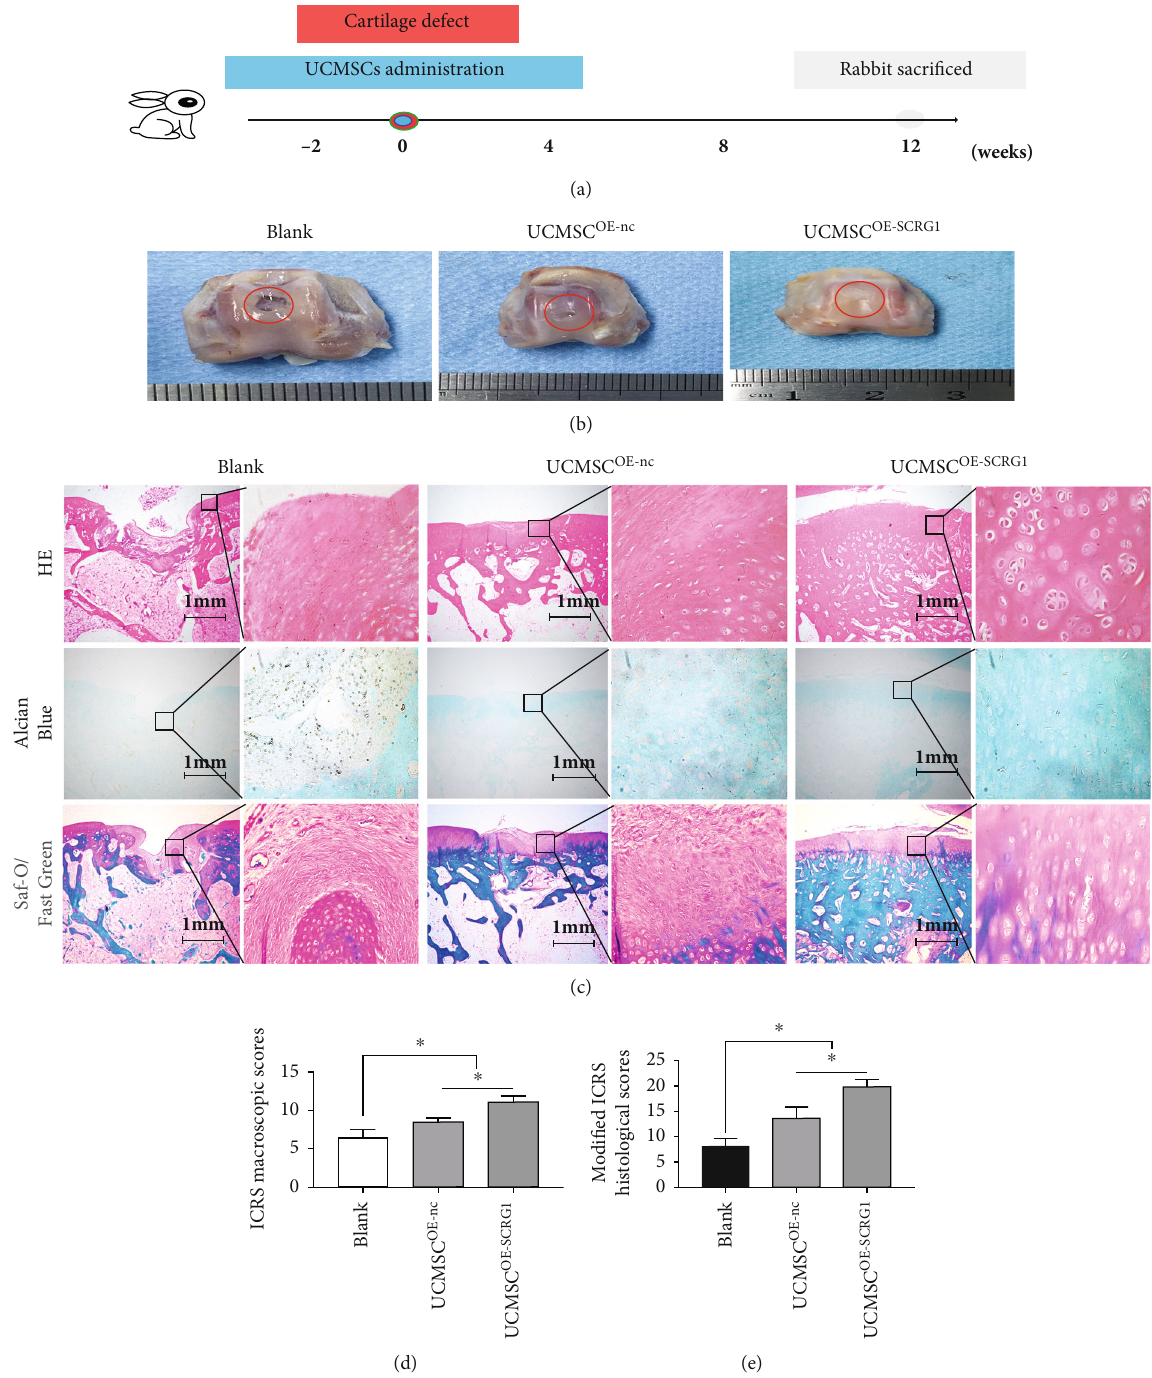
Figure 6: UCMSC OE-SCRG1 promoted cartilage defects repair in vivo . (a) Schematic of cartilage defect model and UCMSC administration. (b) Photographs of cartilage defects at 12 weeks after UCMSC administration. Obvious defects were observed in the blank group, whereas the surface was smooth and regenerated tissue was tightly connected to surrounding cartilage in the OE-SCRG1 group. (c) H&E, Alcian Blue, and Safranin O/Fast Green staining at 12 weeks after surgery. Results showed that defects in the blank group contained necrotic and fi brous tissue, while the OE-SCRG1 group showed considerable chondrocyte regeneration and tissue morphologies similar to normal surrounding cartilage. (d) ICRS macroscopic scores at 12 weeks after surgery. Scores in the OE-SCRG1group were signi fi cantly higher than those in the OE-nc group ( P < 0 : 05 ). (e) Modi fi ed ICRS histological scores at 12 weeks after surgery. Scores were signi fi cantly higher in the OE-SCRG1 group than in the OE-nc group ( P < 0 : 05 ). Scale bar = 200 μ m . N = 6 ; ∗ P < 0 : 05 ( t